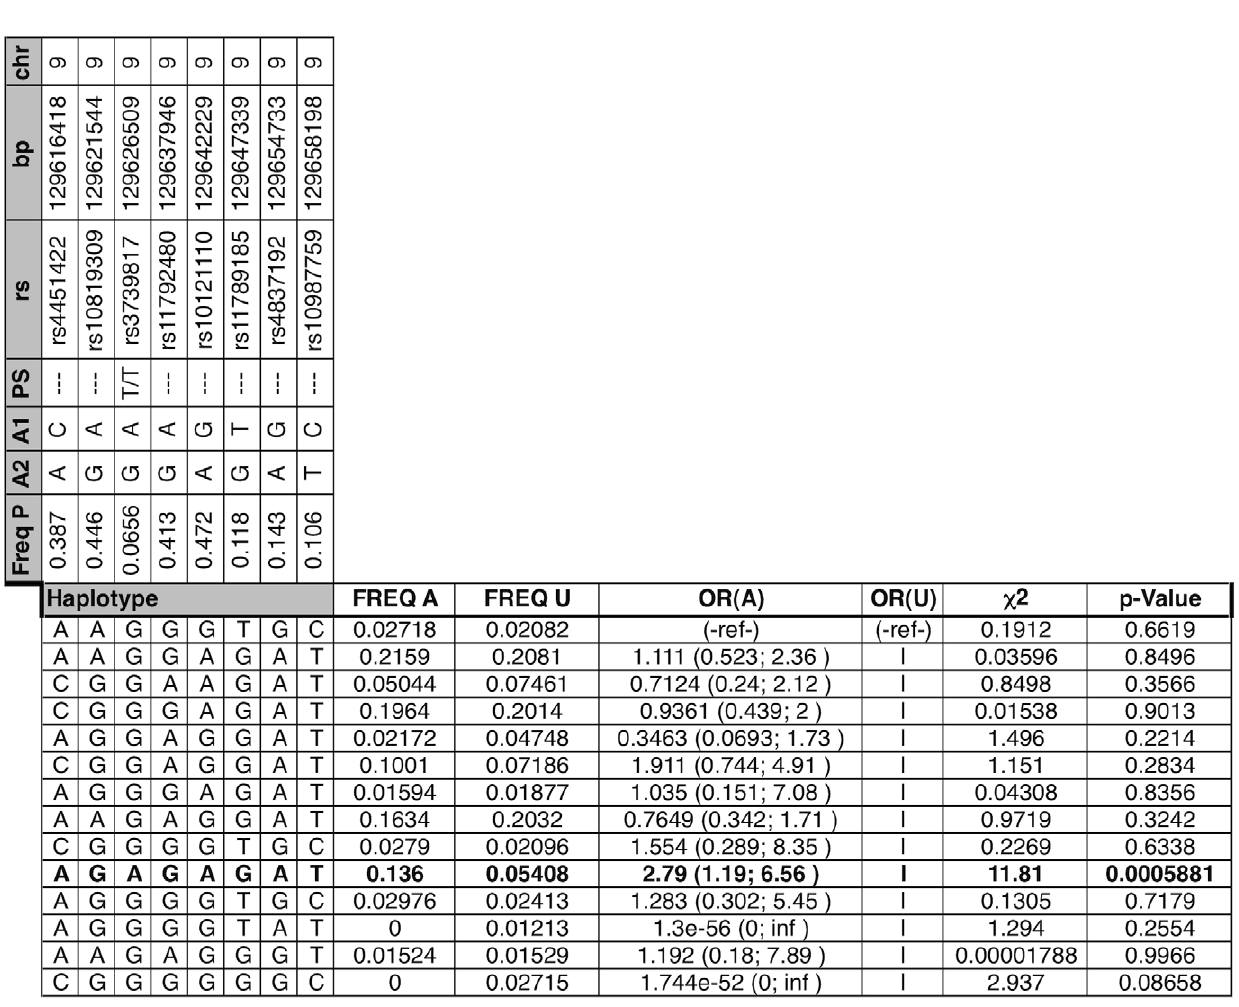
Figure 5. Haplotype Analysis for ENG. ‘‘|’’ indicates haplotype grouped with one above it. Numbers in parenthesis represent 95% confidence interval. OR (A) and OR (U) abbreviate Odds Ratio Affected and Unaffected, respectively. Freq A, U, and P observed haplotype frequency Affected, Unaffected, and Population (control and experimental, this study); PS=Peptide Shift (in this case a conservative instance), italics bases within haplotype signify presence of peptide-shifting variant.